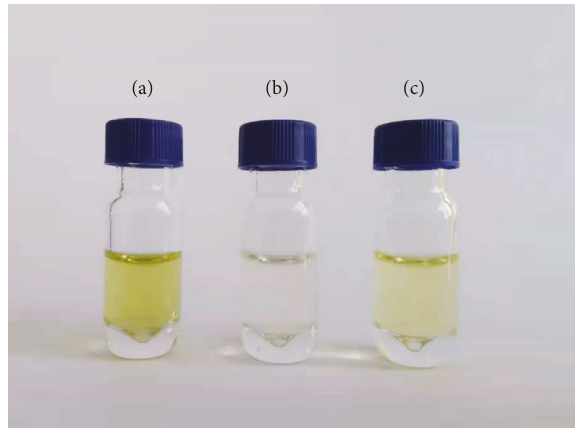
Figure 1: Purification effect maps of chrysanthemum flower samples cleaned up by different purification conditions. (a) QuEChERS purification (simple matrix), (b) QuEChERS purifi- cation (complex matrix), and (c) Sin-QuChERS Nano